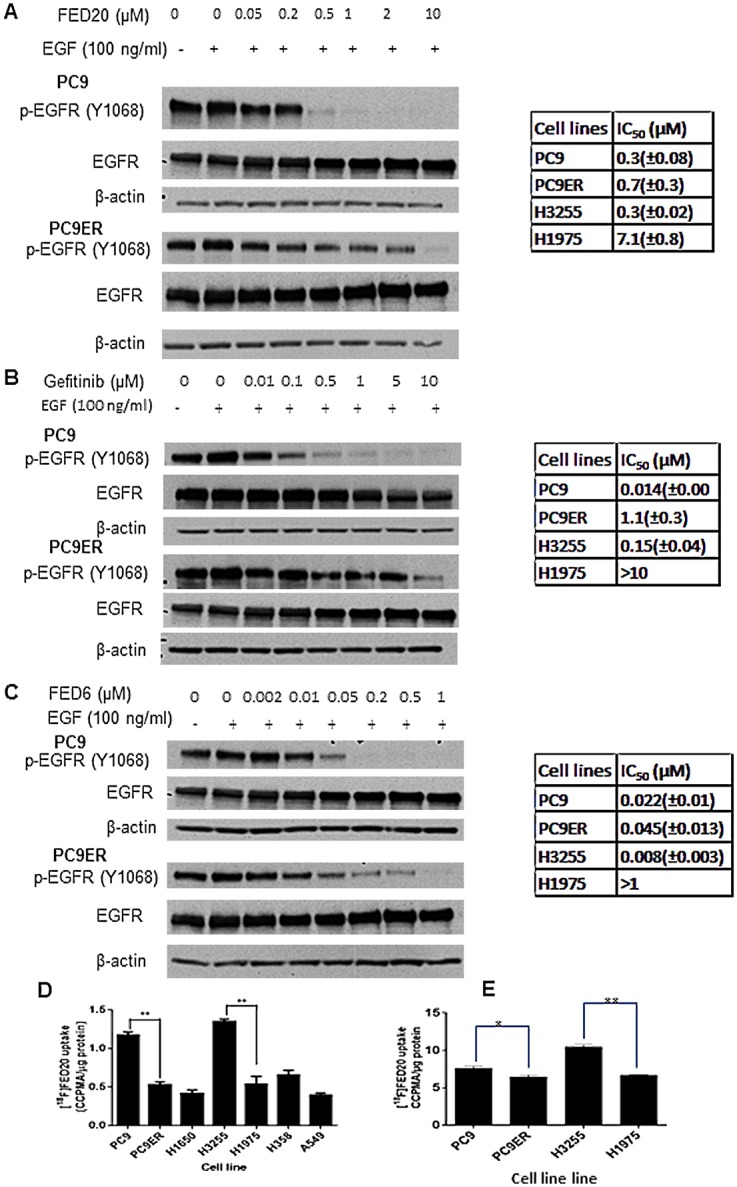
Comparative affinities FED20, gefitinib and FED6 in TKI sensitive and resistant NSCLC cell lines and [18F]FED20 uptake in the cell lines.Typical of p-EGFR Y1068 and EGFR protein expression following 3 h incubation with increasing concentrations of A. FED20, B. gefitinib, or C. FED6 in PC9 and PC9ER cells; summary IC50 values for all cell lines determined from densitometry analysis of p-EGFR Y1068 in the western blots are shown. D. Protein normalised uptake of [18F]FED20 in TKI sensitive and resistant cells following 1 h incubation with 0.55 MBq of [18F]FED20 (low specific activity; 7.3 GBq/μmol). E. Protein normalised uptake of [18F]FED20 in TKI sensitive and resistant cells following 1 h incubation with 0.74 MBq of [18F]FED20 (higher specific activity; 52 GBq/μmol). (* = p < 0.05, ** = P < 0.01).